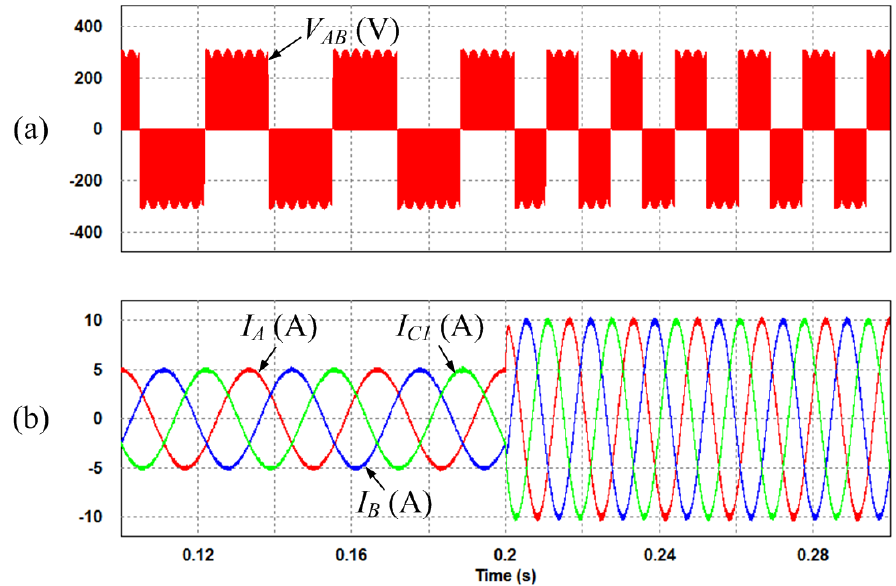
Figure 9. Simulation results of dynamic response for the three-phase load: ( a ) output line-to-line voltage; ( b ) three-phase output currents.